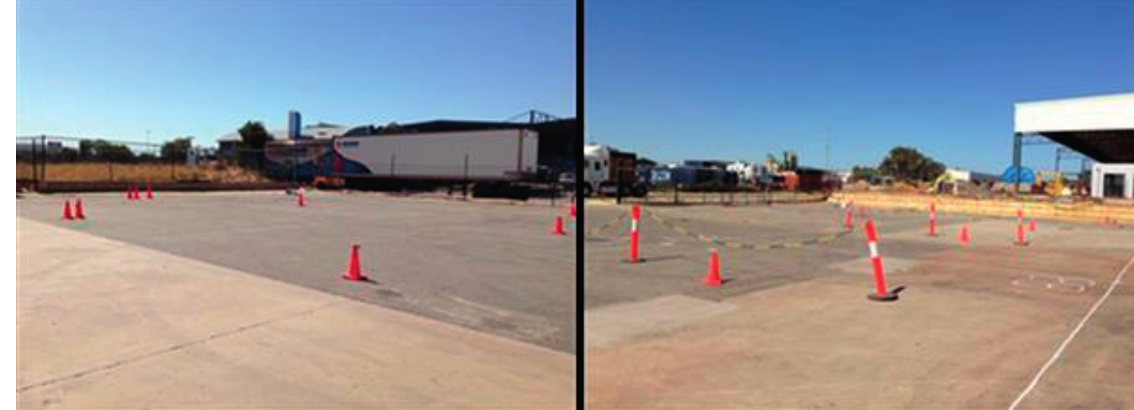
Figure 1. Field view of the study area.